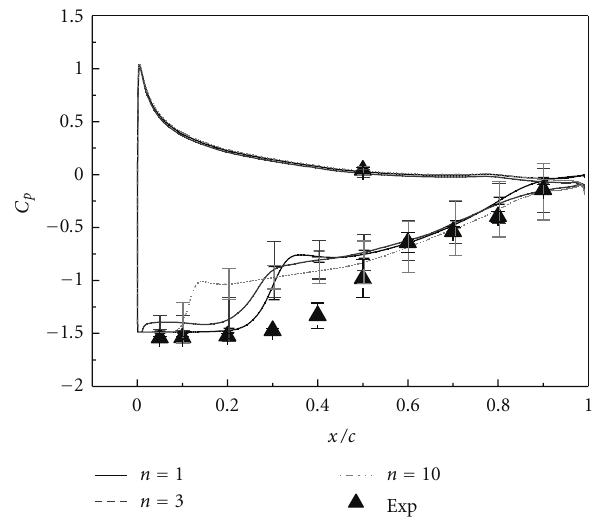
Figure 9: Computed versus measured pressure coe ffi cients for di ff erent n values, Singhal cavitation model, σ = 1 . 49, Re = 750,000, α = 6 ◦ . The lines represent the mean values and V ∞ = 5m/s, and the error bars represent the level of fluctuations.